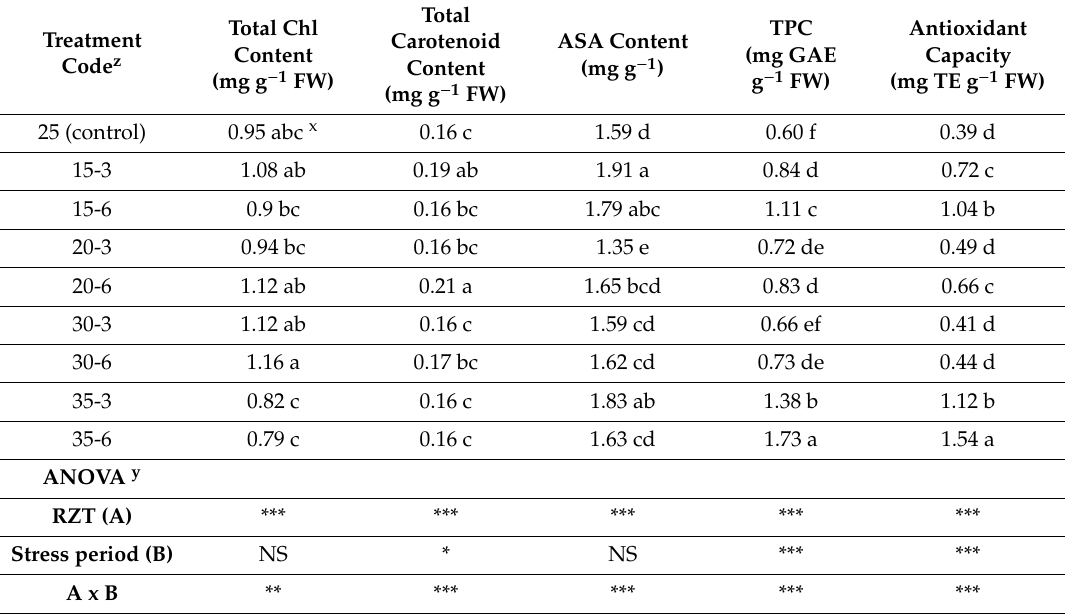
Table 1. Total chlorophyll (Chl), total carotenoid, ascorbic acid (ASA), total phenolic contents (TPC), and antioxidant capacity in coriander on day 18 after transplanting under di ff erent root-zone temperatures and stress